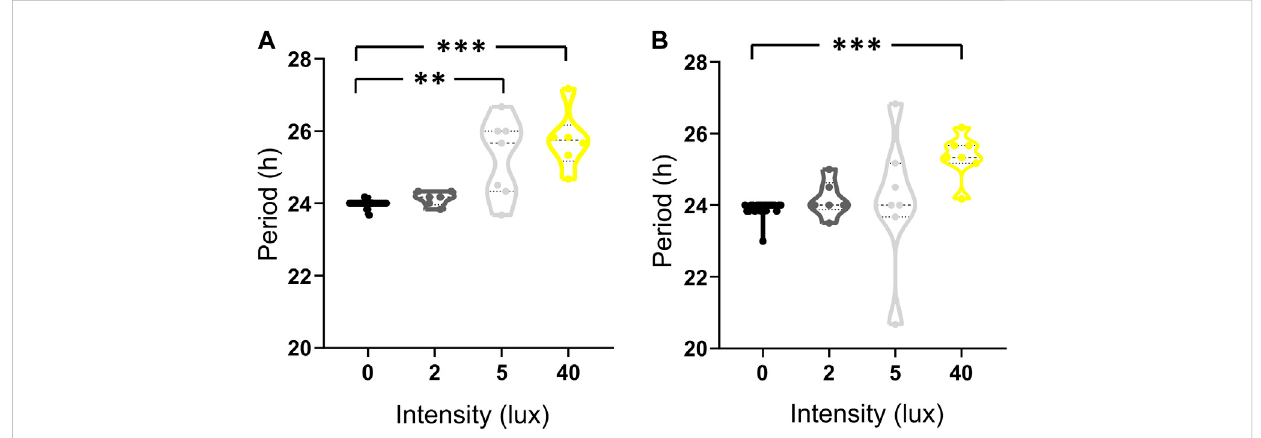
FIGURE 5 The transition from LD to LA or LL affects the individual daily activity periods of stridulation (A) and locomotion (B) in a light intensity dependent manner. LD (before transition, black, n = 20), LA 2 lux (dark grey, n = 7), LA 5 lux (light grey, n = 7) and LL 40 lux (yellow, n = 6, n = 7 for stridulation and locomotion, respectively) treatments. * p < 0.05, ** p < 0.01, *** p < 0.001.